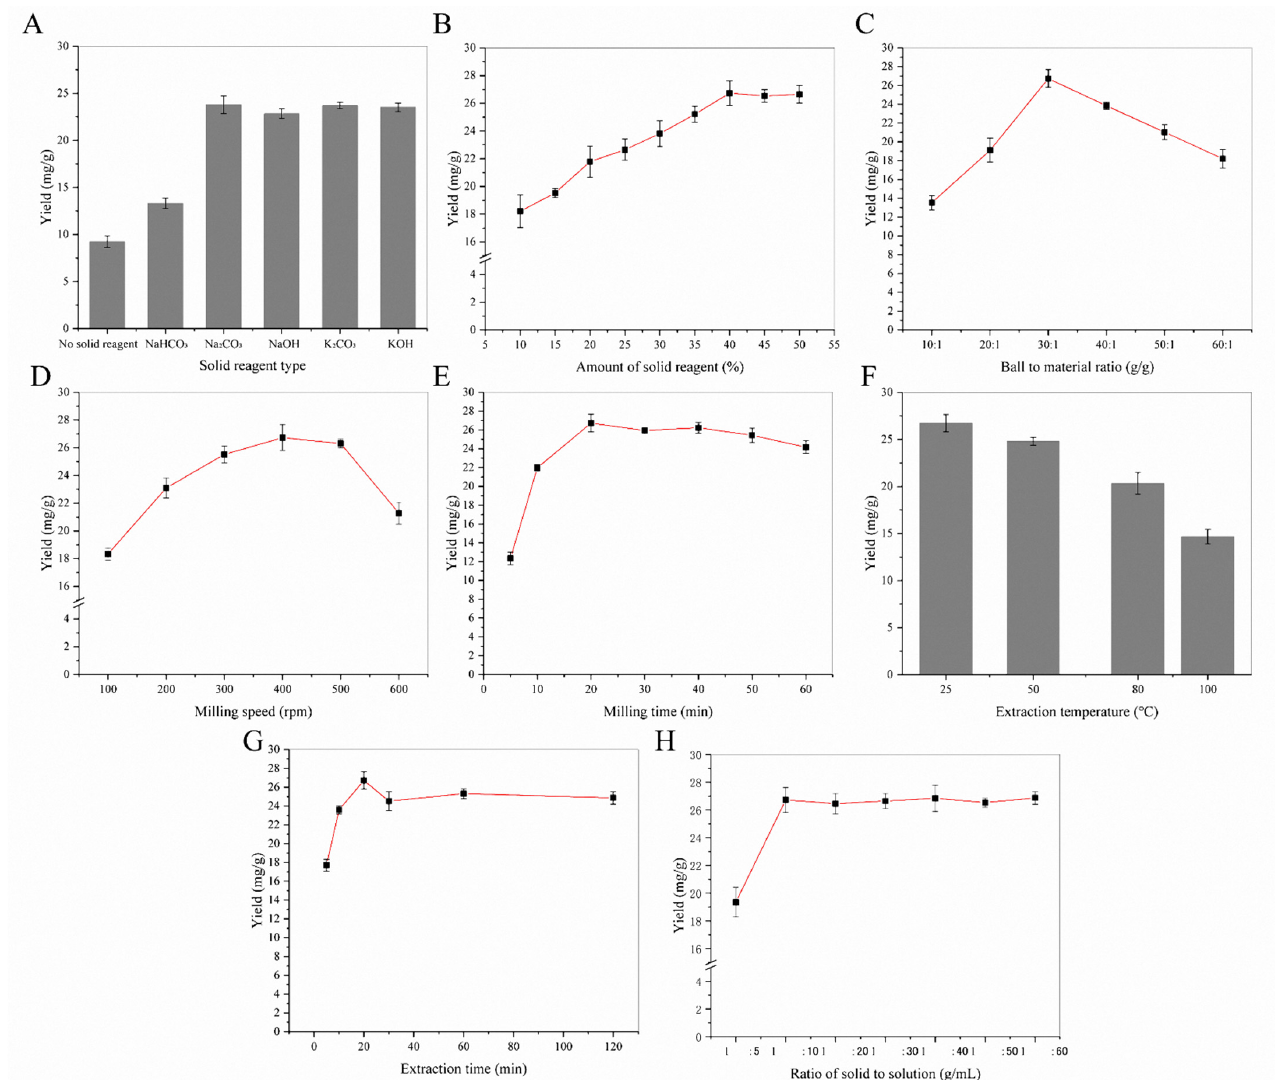
Figure 1. The single-factor experiment of MCAE: ( A ) the effect of solid reagent type; ( B ) the effect of solid reagent amount; ( C ) the effect of ball-to-material ratio; ( D ) the effect of milling speed; ( E ) the effect of milling time; ( F ) the effect of extraction temperature; ( G ) the effect of extraction time; ( H ) the effect of the solid-to-solution ratio.